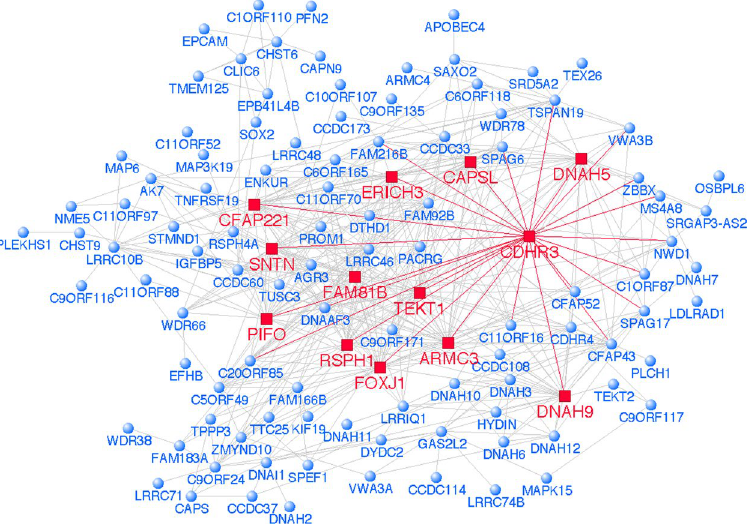
Figure 5. Differential gene network comparing HDM S wheezers versus nonatopic controls/HDM S nonwheezers. Gene co-expression network analysis (WGCNA) was employed to construct the gene networks and unbiased correlation patterns were utilized to reconstruct the underlying wiring diagram of the mucociliary clearance module “A”. CDHR3 is identified as a hub and dominant hubs are highlighted in